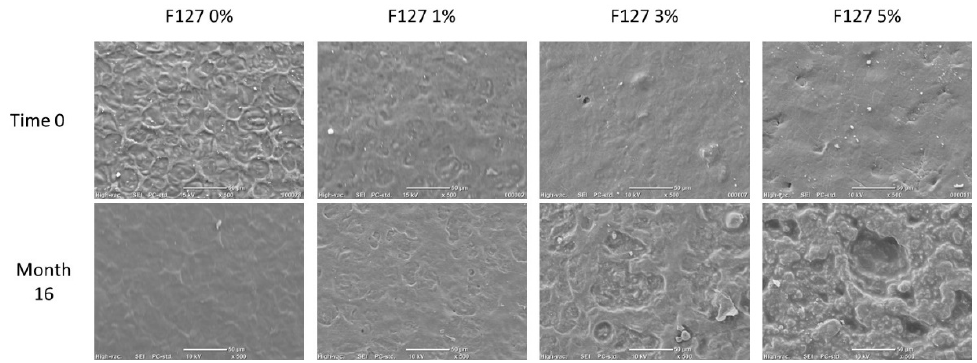
Figure 2. SEM images for the surface (500×) of composite films of corn starch-chitosan with pluronic F127 at ratios of 0%, 1%, 3%, and 5% stored for 0 and 16 months.